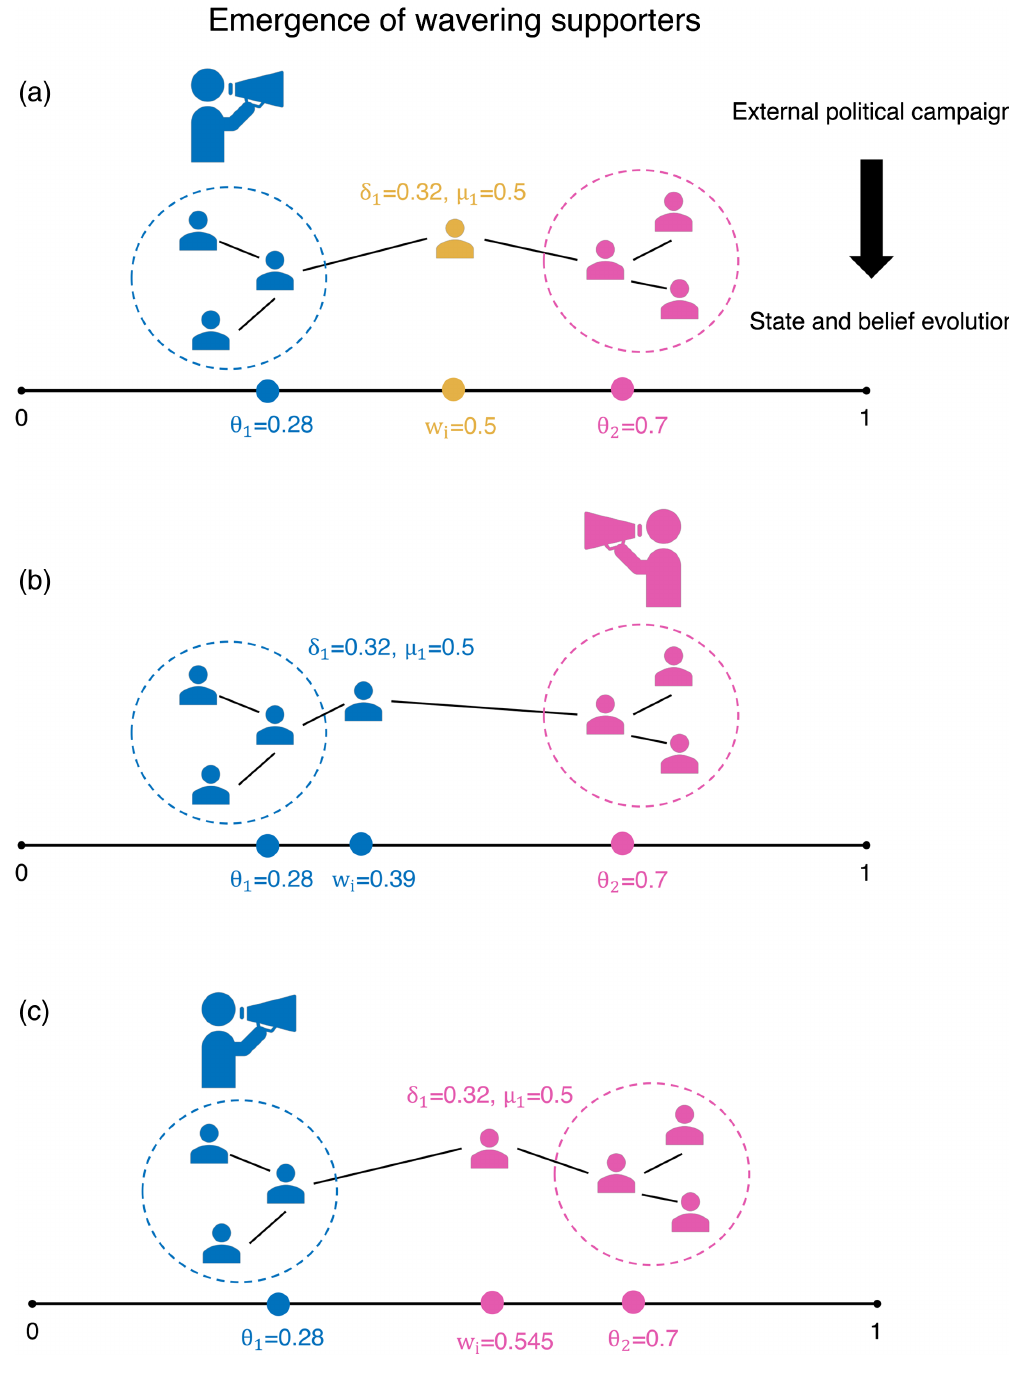
FIG. 15. Emergence of wavering supporters. (a),(b) The undecided individual i updates with viewpoint blue and directly becomes a blue supporter with its belief w i converging to θ 1 . (b),(c) Blue supporter i updates with viewpoint red and directly becomes a red supporter with its belief w i converging to θ 2